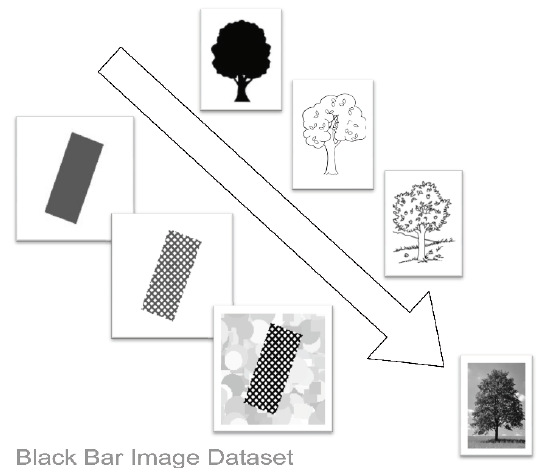
Figure 2. Scalability of the Black Bar Image Dataset (BBID). The image resumes the BBID concept as a model of images of the real word. The arrow is oriented in the direction of the increase of: the number of elements, presence of information, the complexity, and presence of noise. This direction also involves an increase in difficulty to estimate and control features in images of the real word, whereas for a synthetic image dataset—like BBID—all parameters are controllable; an interesting and powerful feature of BBID is the possibility to evolve images up to converge to real images. Images were 140 × 140 pixels in size, featured by a gray scale color-map (values between 001 “black” and 256 “white”). Each image contains a rectangular shape (the “bar”) as a ‘main element’, 100 pixels in length, positioned in the center. Each image was featured by different sizes and orientations of the bar: six sizes were possible for the bar width (4, 6, 9, 15, 24 or 42 pixels) and ten orientations (0°, 10°, 20°, 30°, 40°, 50°, 60°, 70°, 80° or 90° with respect to the vertical direction). A “battery” of images is composed of a collection of 60 items covering all the sizes and orientations, featured by the same texture and color for the bar, and the same texture and color for the background. Panel b of Figure 3 shows an example of the battery of images tested in the first experimental condition (uniformly-filled black bar, on a white background). In each test, HMAX must classify all the items of a battery in two classes. Two items are defined as class-representative (highlited in Figure 3 Panel B), and presented during the training phase. During the classification phase, HMAX compares each item to the class-representative items, to classify it in one of two classes on the basis of geometrical and luminance similitude criteria.